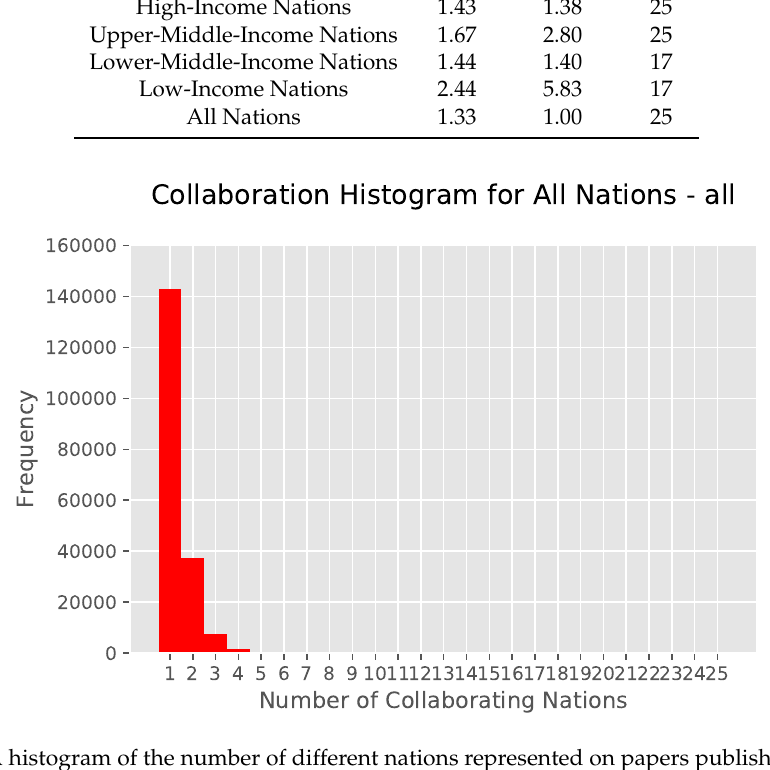
Figure 3. A histogram of the number of different nations represented on papers published in MDPI journals between 1996 and